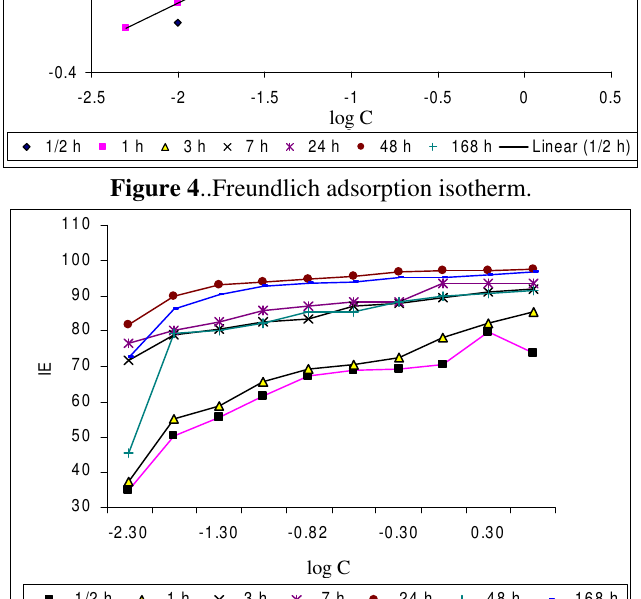
Figure 5 . Frumkin adsorption